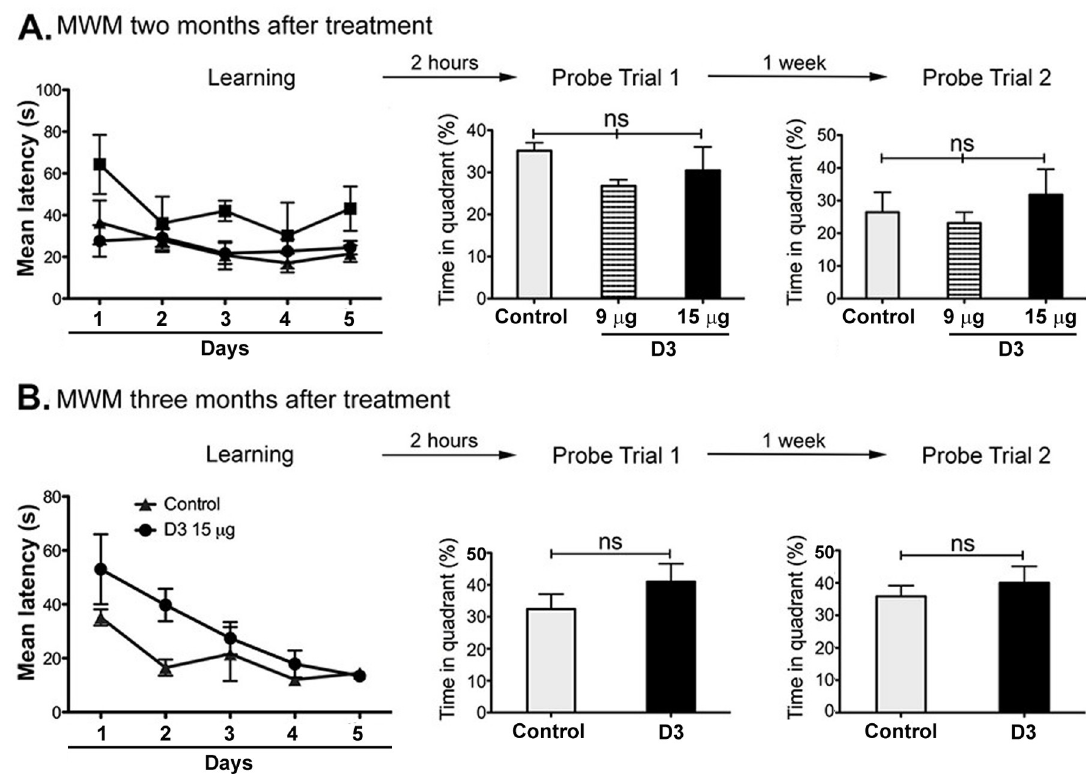
Fig 7. D3 impairment in STM consolidation after acute ICV injection is reversible. Mice were trained and tested through the Morris Water Maze (MWM) as previously described. Controls (n = 5), D3 9 μ g (n = 3) and D3 15 μ g (n = 5). No learning or memory deficits were observed (A) two months, nor (B) three monts after treatment, implying reversibility of the effects. This experiment was performed twice independently, obtaining equal results.